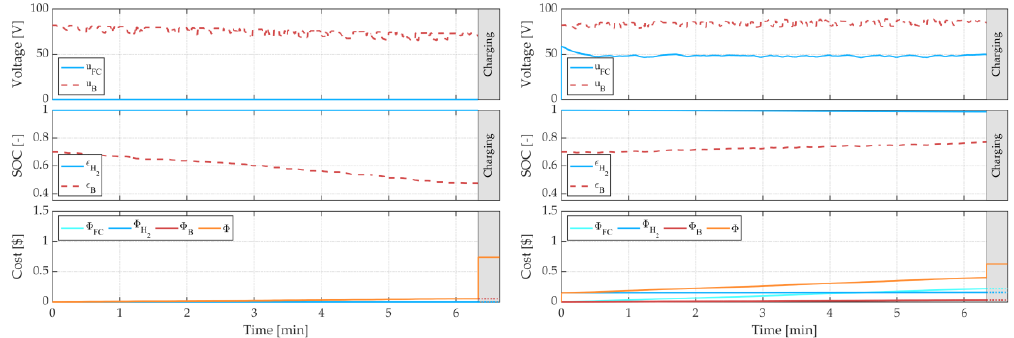
Figure 20. Voltages, state-of-charge and costs achieved over REAL by H-EMS ( on the left ) and S-EMS ( right ).